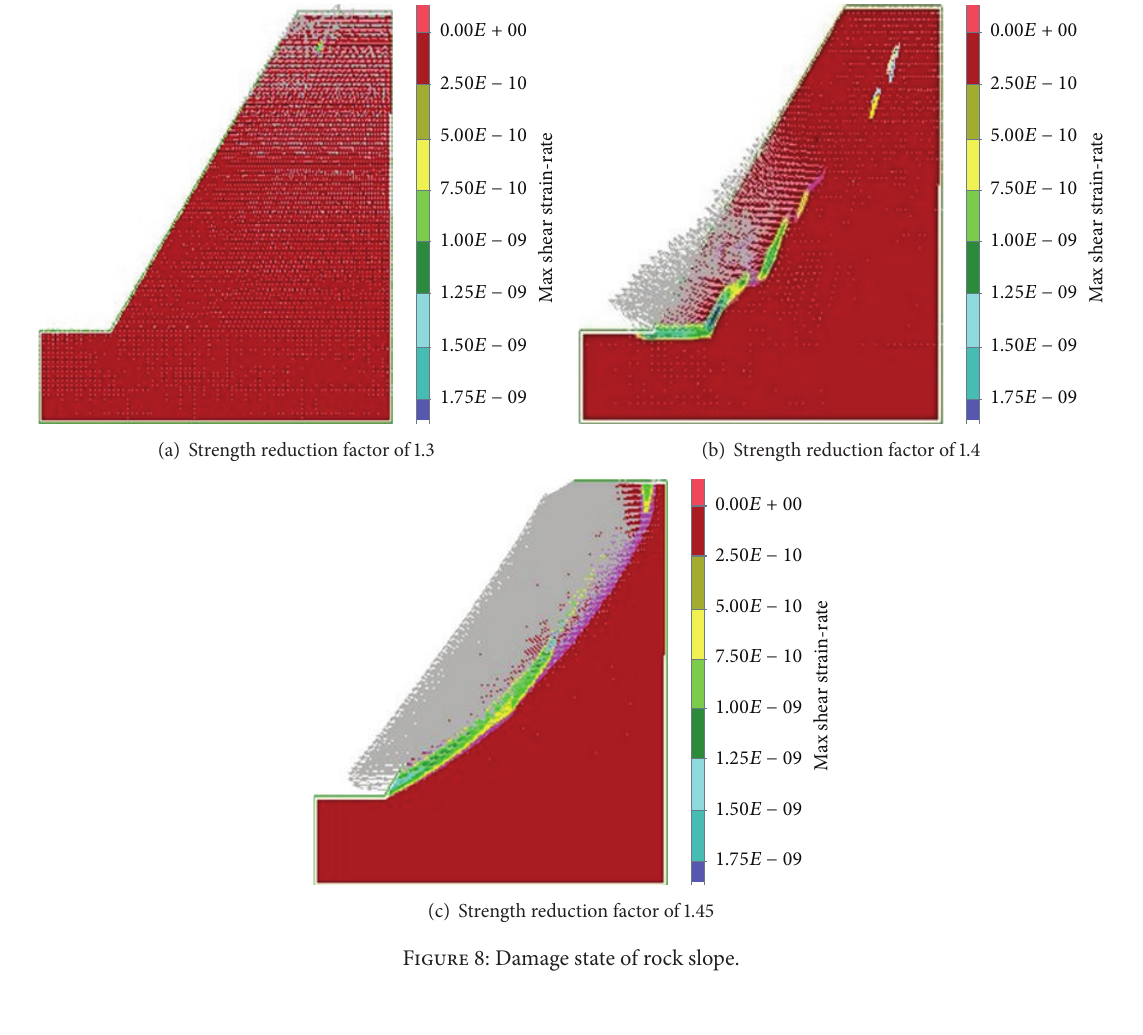
rock slope in western China, this new method is